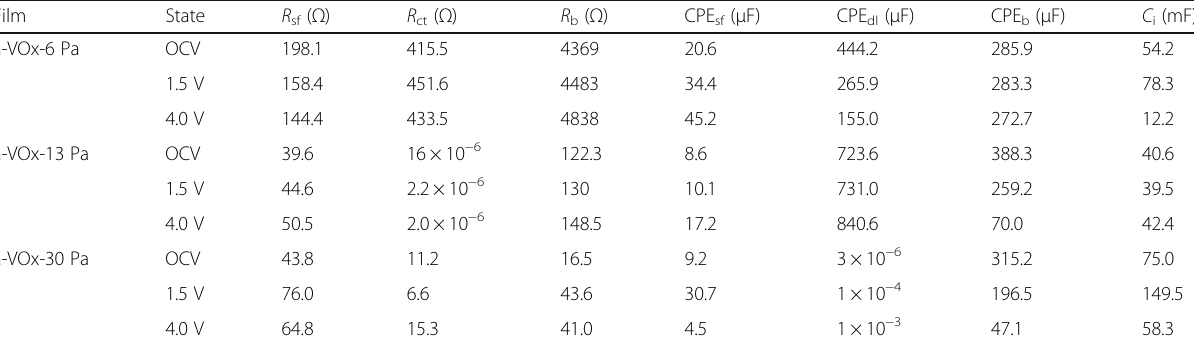
Table 6 Li-ion battery impedance analysis of a-VOx